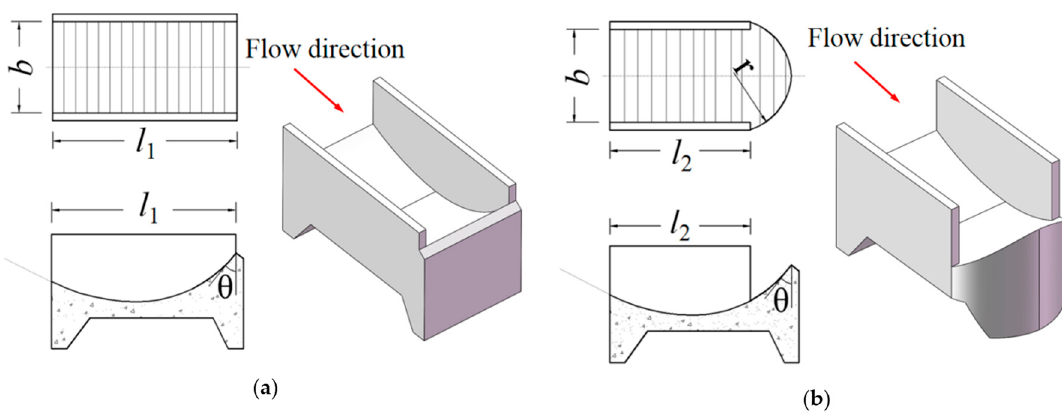
Figure 3. Flip-bucket types for the testing: ( a ) continuous bucket (CB) and ( b ) tongue-shaped bucket (TB) ( θ represents the bucket angles, l 1 represents the length of the flip bucket, b represents the width of the flip bucket, l 2 represents the sidewall length of the TB, and r represents the radius of the TB).